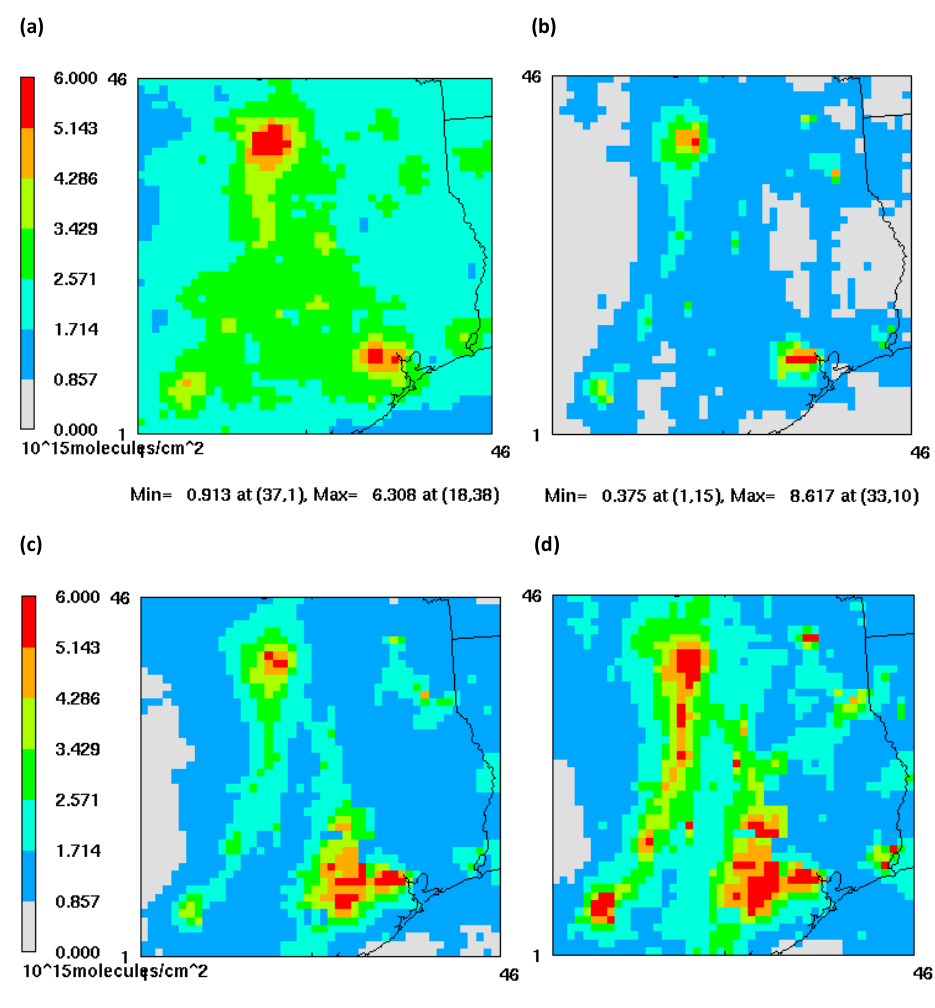
Fig. 5. Same as Fig. 4, but for the August–September episode.